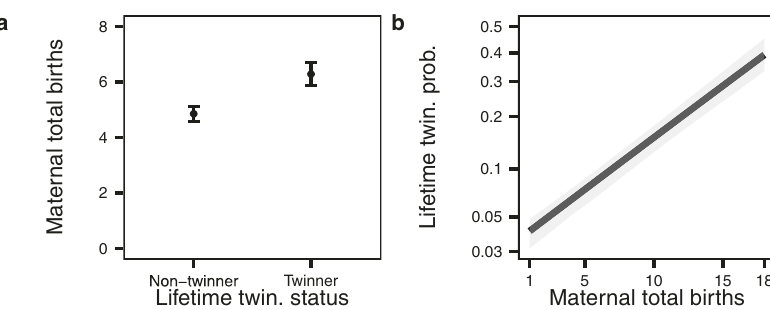
Fig. 1 Relationship between twinning status and the number of maternal total births. The plots represent marginal predictions ( a : points, b : line) ± CI 95% ( a : error bars, b : grey area) from the fi ts of generalised linear mixed-effects models including the variable depicted on the x -axis as fi xed effect and variation between populations as a random effect ( n = 21,290 mothers in total, from 8 populations; see Table 1). a Twinners had more total births (6.29; CI 95% : 5.89, 6.72) than non-twinners (4.86; CI 95% : 4.58, 5.12), and ( b ) the probability of a mother being a twinner was positively related to a mother ’ s total number of births. Note that the y -axis is represented on a logit scale so as to display the outcome of the logistic (binary) regression as a straight line with an estimated slope β of 0.162 (CI 95% : 0.145, 0.178). Model summary statistics are provided in Supplementary Tables 1,